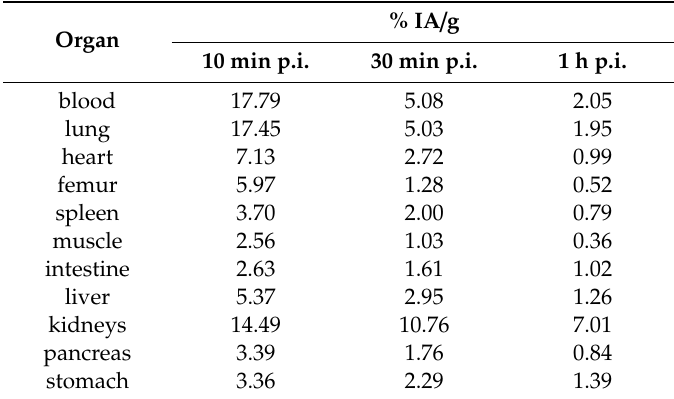
Table 2. Biodistribution profile of [ 177 Lu]Lu- 1 in BALB / c mice after 10 min, 30 min and 1 h p.i. (30–40 MBq, 0.8 nmol). Values are expressed as % IA / g.